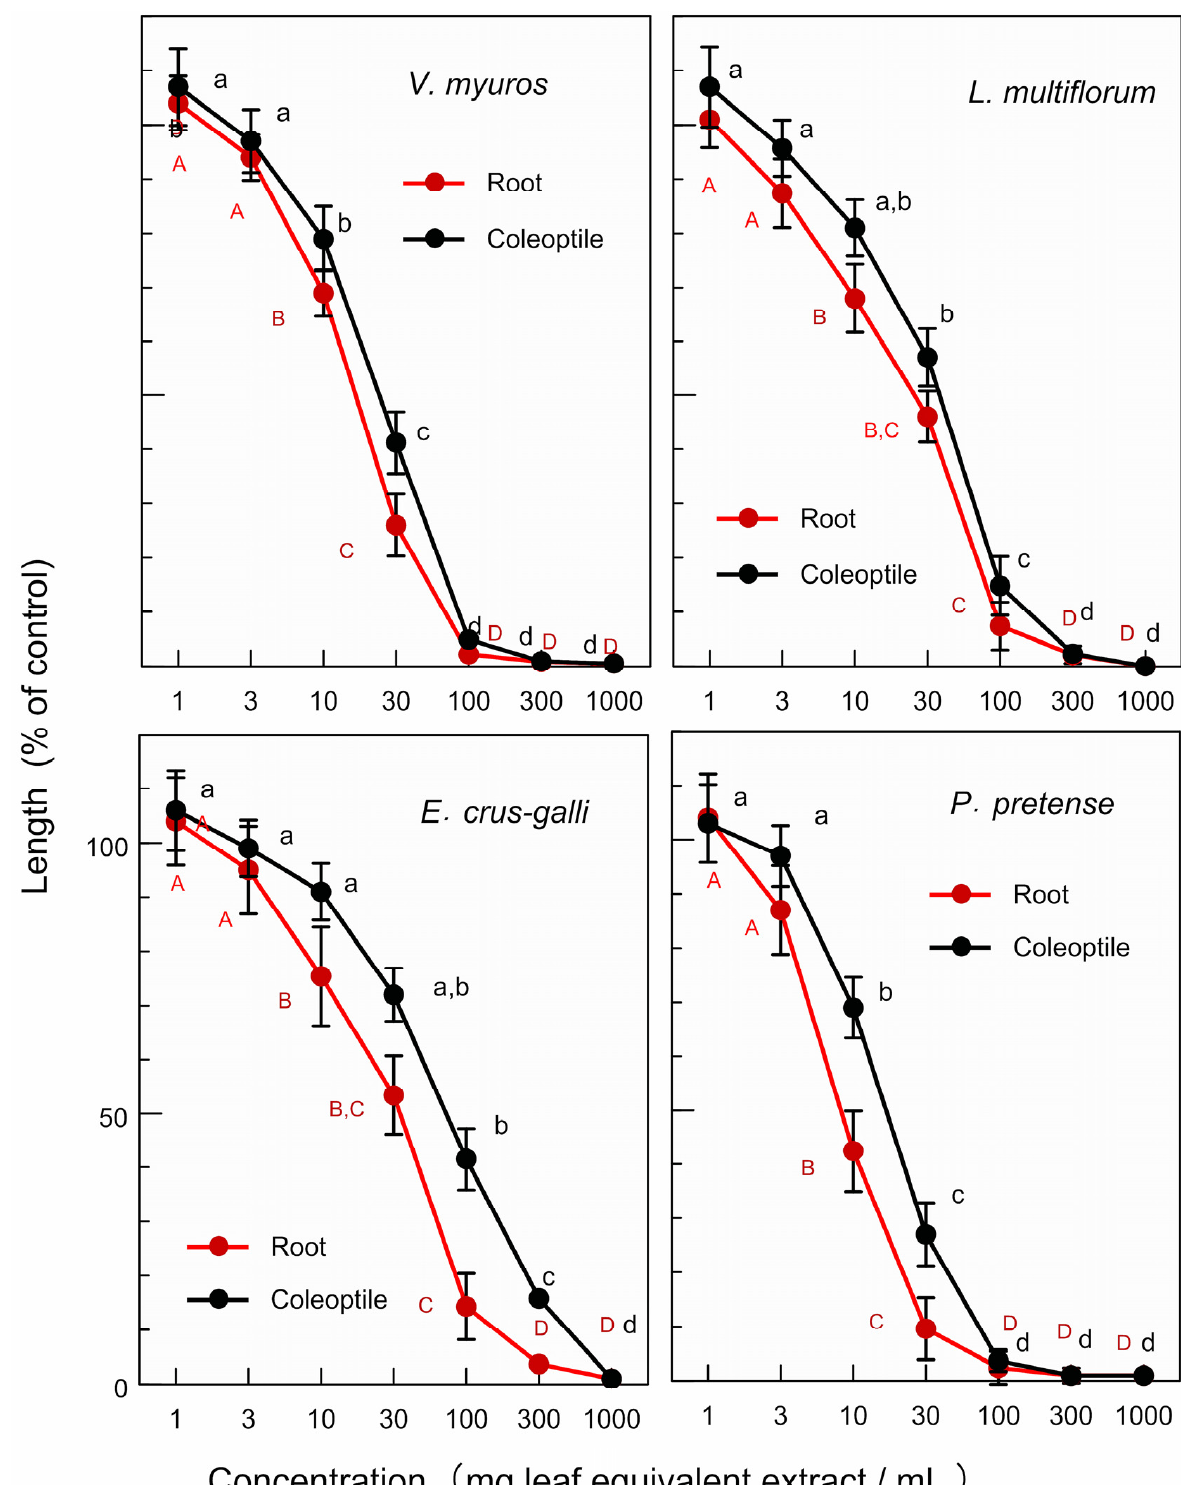
Figure 2. Effects of M. glyptostroboides leaf extracts on the growth of roots and coleoptiles of V. myuros , L. multiflorum , E. crus-galli , and P. pretense . Concentration (mg leaf equivalent extract/mL) indicates the concentration of tested sample corresponded to the extracts from 1, 3, 10, 30, 100, 300, and 1000 mg leaves. Means ± SE from 4 independent experiments with 10 seedlings for each determination are shown. Different letters in the same panels indicate significant differences (Tukey’s HSD test, p ≤ 0.05).